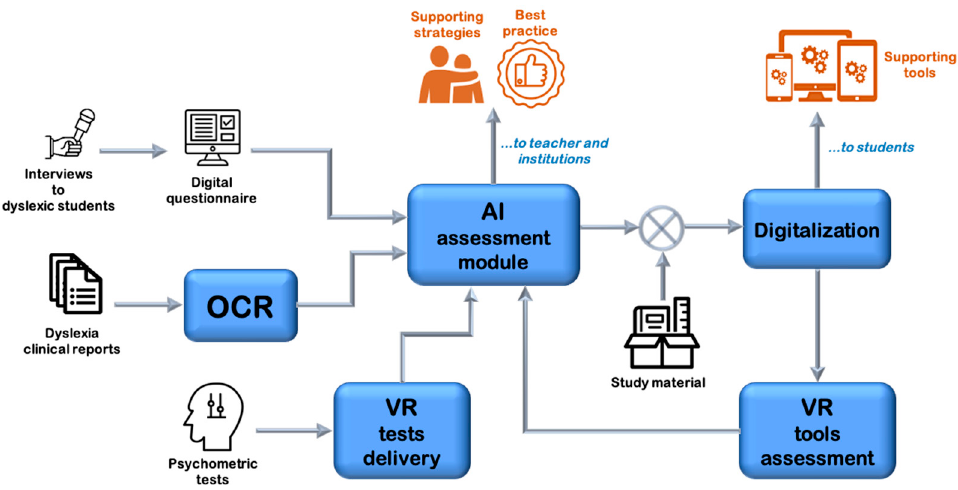
Figure 8. Block diagram of the final implementation of BESPECIAL.